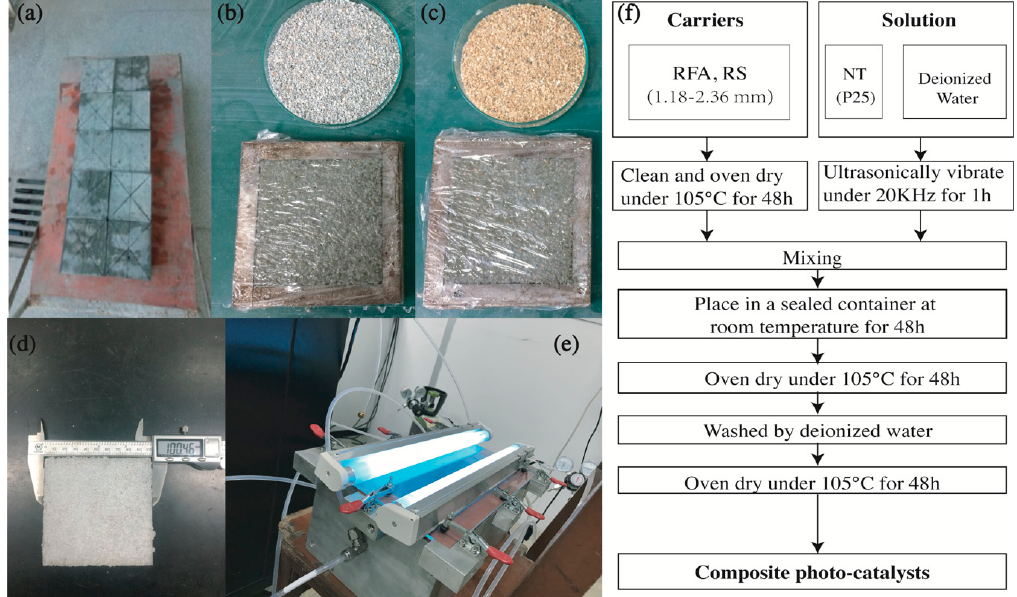
Figure 1. Experimental photos: ( a ) Recycled concrete prepared in the laboratory; ( b ) Recycled fine aggregate (RFA) group; ( c ) River sand (RS) group; ( d ) final specimen containing NT@RFA; ( e ) photocatalytic reactor; and ( f ) Composite photocatalyst (CP) preparation